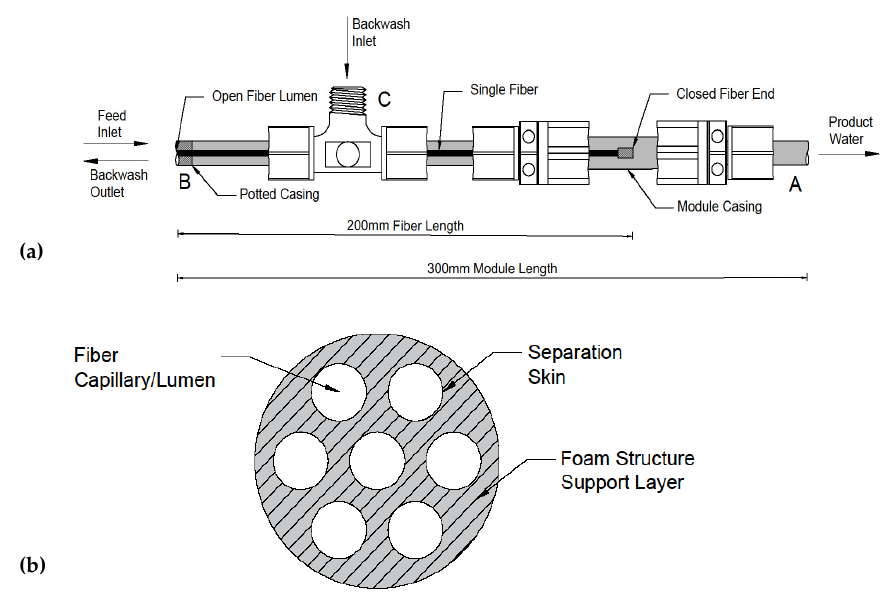
Figure 2. Pressure–driven inside–out membrane: ( a ) module; ( b ) fiber Figure 2. Pressure – driven inside – out membrane: (a) module; (b) fiber cross – section.